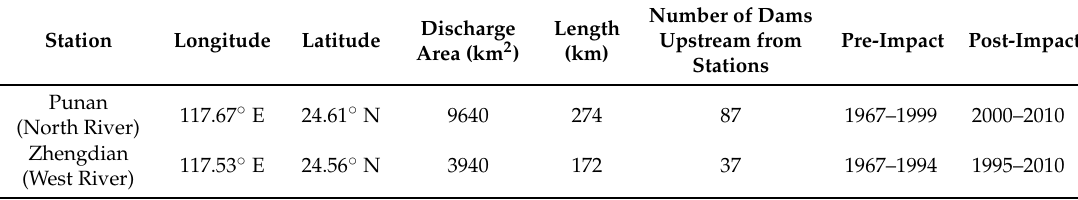
Table 1. The streamflow for two gauging station in the JRW.